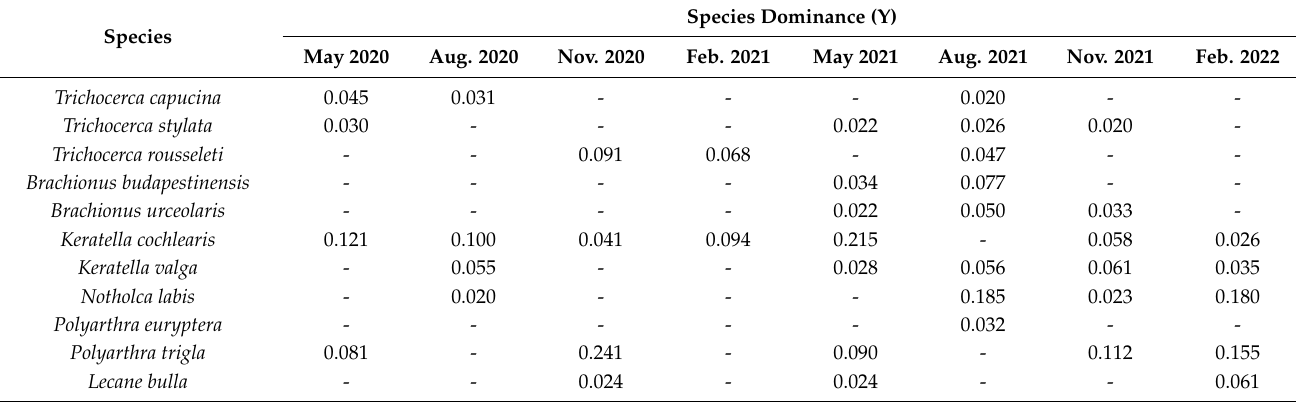
Table 2. Dominant species and dominance of